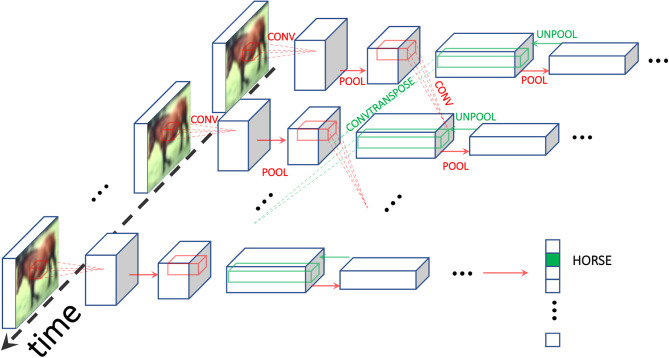
Schematic of the architecture used. We use Equilibrium Propagation (EP) to train a recurrent ConvNet receiving a static input. Red (resp. green) arrows depict forward (resp. backward) operations, with convolutions and transpose convolutions happening through time. At the final time step, the class prediction is carried out. The use of RNNs is inherent in the credit assignment of EP which uses of the temporal variations of the system as error signals for the gradient computation.